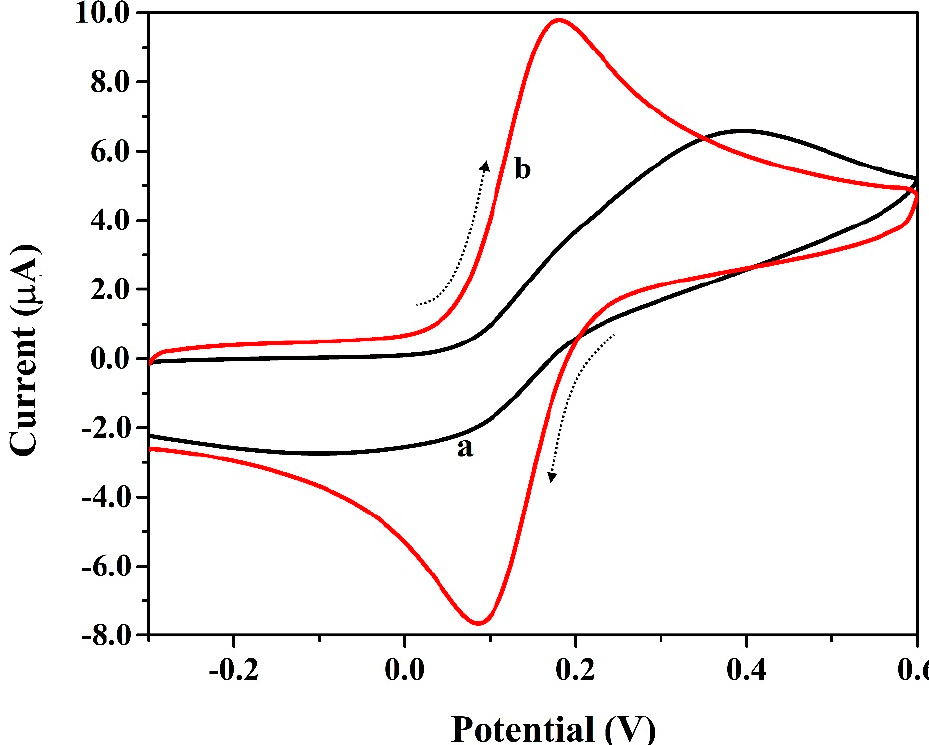
Figure 3. Cyclic voltammograms for K 4 [Fe(CN) 6 ] (1.0 mm) in KCl (0.1 M) at the surface of BCNTPE (curve-a) and P(PAN)LCNTPE (curve-b) having a potential window of − 0.3 V to 0.6 V and a scan rate of 0.1 Vs − 1 .